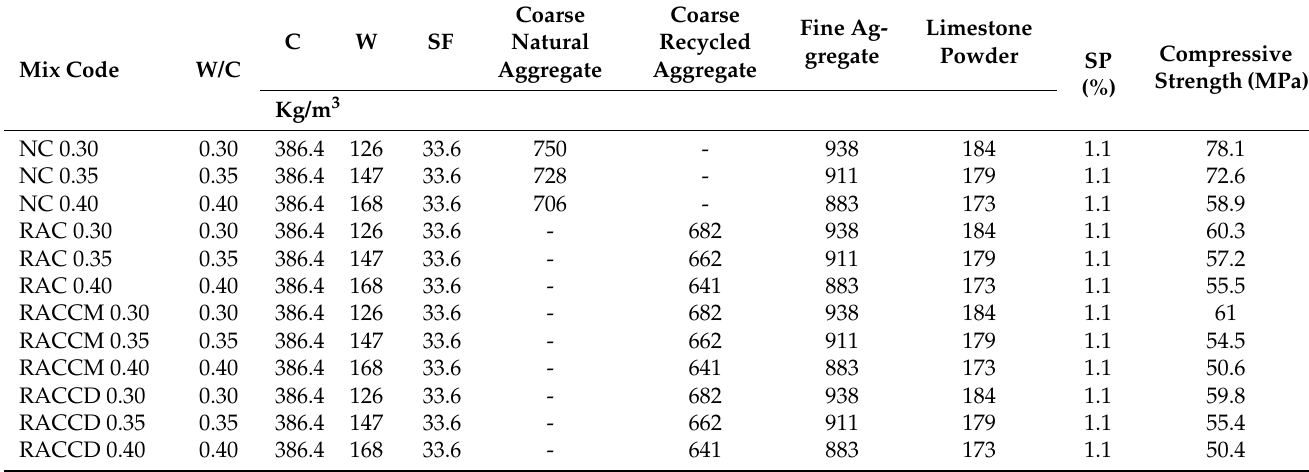
Table 4. Mix proportion, slump, and compressive strength.